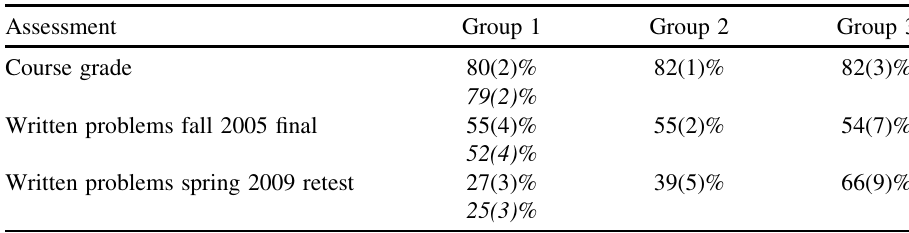
TABLE II. Major group average performance on their overall course grade, on the written questions in the fall 2005 final exam and on the written questions in the spring 2009 senior retest. The numbers in italics show the data for group 1 if mathematics majors and civil and environmental engineering majors are